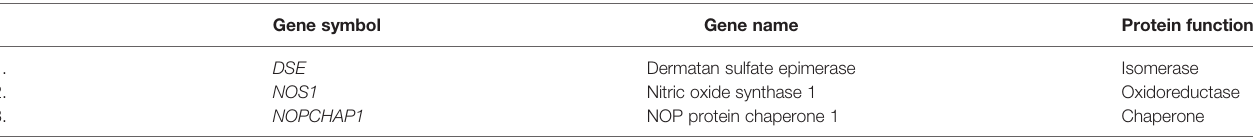
TABLE 4 | mRNA predicted to be reduced by hsa_circRNA_101145 and hsa_circRNA_001896 downregulation.